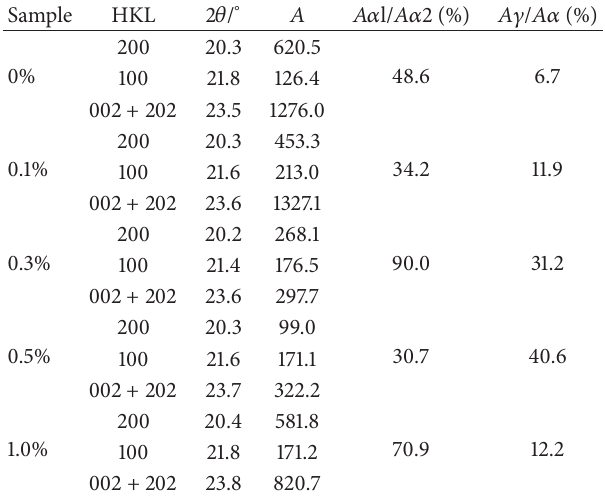
Table 1: The XRD parameters of the PA6/LiCl composites.